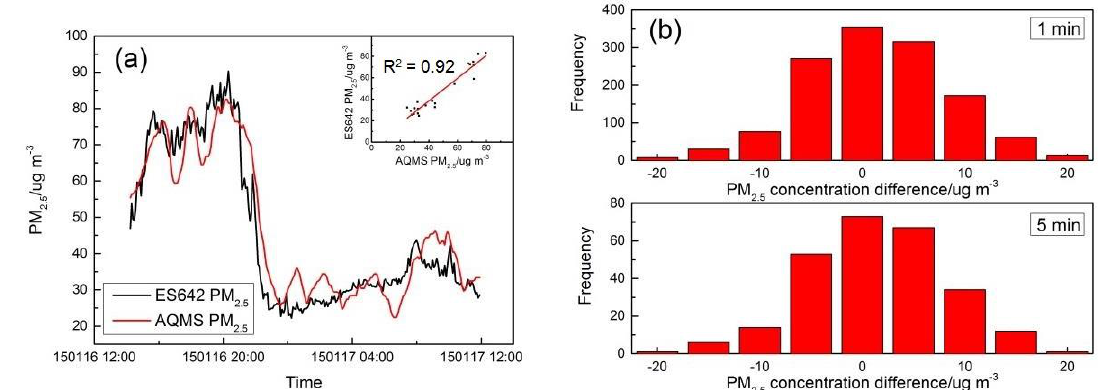
Figure 7. Comparison of the PM 2.5 concentration from MAS and AQMS. ( a ) Time series of concentration; ( b ) histogram of the concentration difference in the 1-min and 5-min time average.